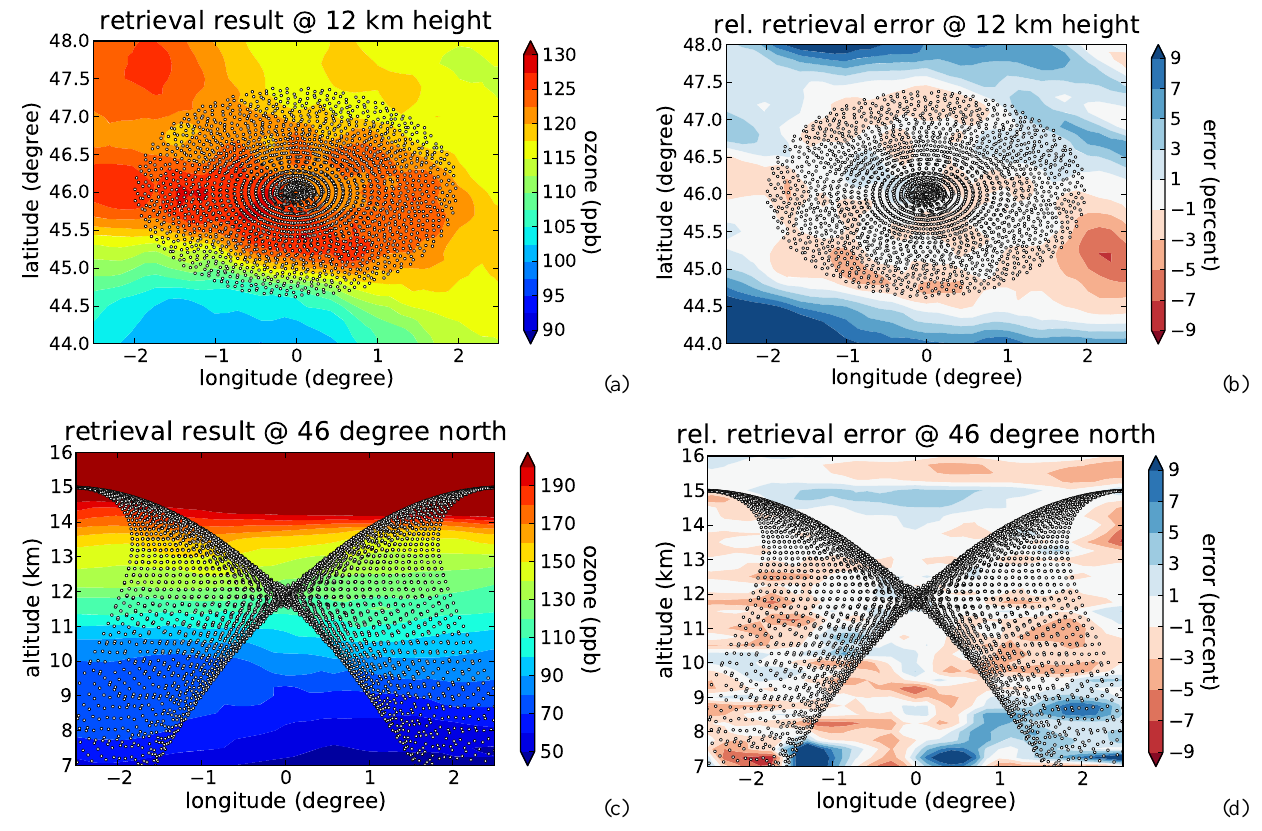
Fig. 5. The retrieval result of the baseline setup with added instrument noise. (a) Shows the retrieved ozone values at 12km height while (b) depicts the relative error in percent compared to the true values. (c) and (d) Shows the same information for a vertical cut at 46 ◦